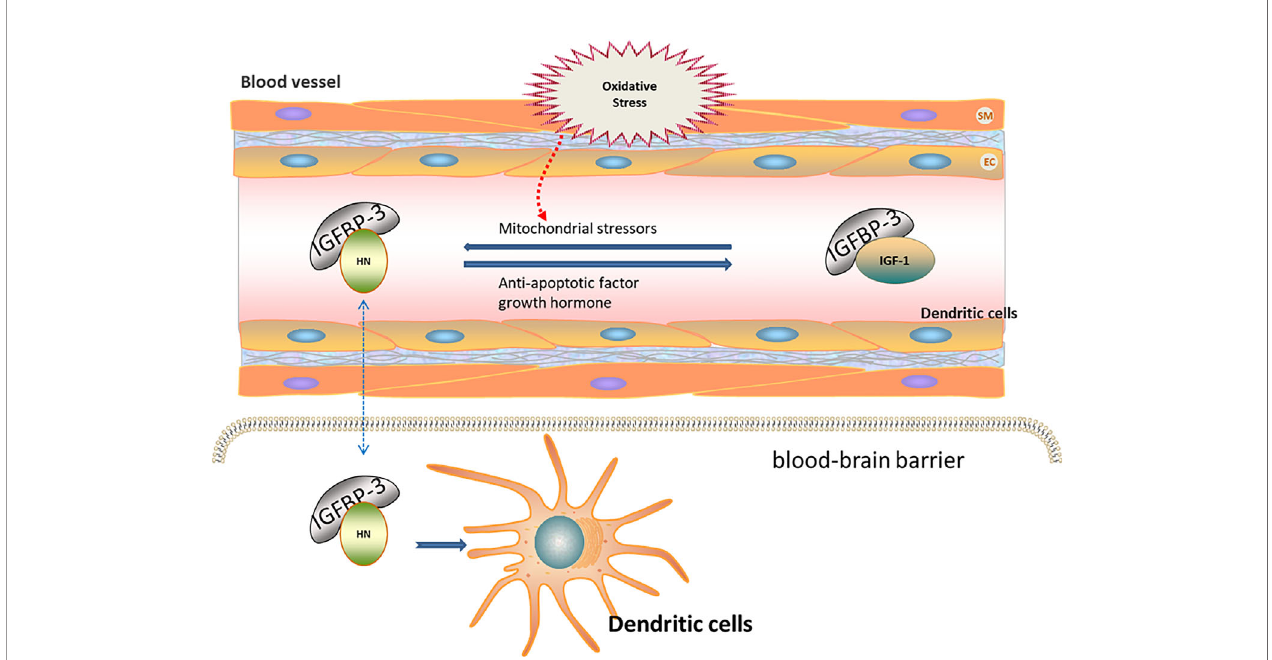
FIGURE 1 | Regulation of HN expression under oxidative stress. HN levels in peripheral blood are regulated by IGF and IGFBP. IGFBP-3 is the main component of IGFBP in peripheral blood, with high af fi nity to HN. IGFBP-3 may transport HN through the blood – brain barrier (Blue dotted arrow), thereby reducing ROS and further protecting nerve cells. Growth hormone down-regulates HN levels in peripheral blood through the high expression of IGF-1. Mitochondrial stressors, such as serum deprivation and chemotherapeutic drugs, increase HN expressions. Anti-apoptotic factors decrease HN expressions. HN levels under oxidative stress may be regulated by increasing IGFBP-3 levels or inhibiting IGF-1